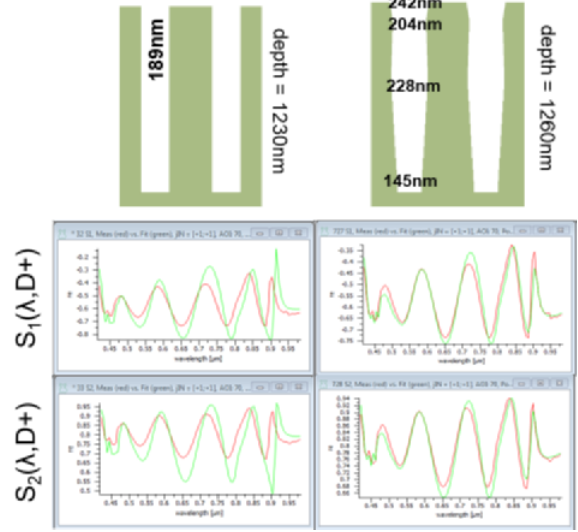
Fig. 3. Modelled (green curves) and measured (red curves) spectra of S1(λ) and S2(λ). D+ denotes diagonal linear illuminating polarization of 45°. Rotation angle is γ = 30° and incident angle Ψ = 60°. The left (right) column represents the best fit for an ideal binary (realistic)